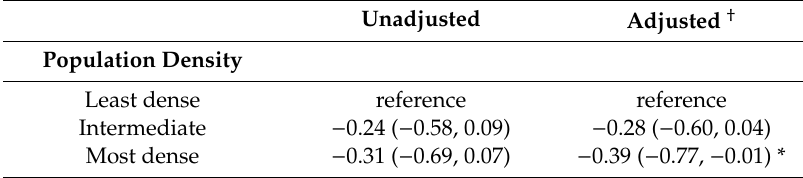
Table 5. Mean di ff erence in the diet quality score (95% CI) of participants living in more densely populated areas versus the least populated areas, results from unadjusted and adjusted LMMs.